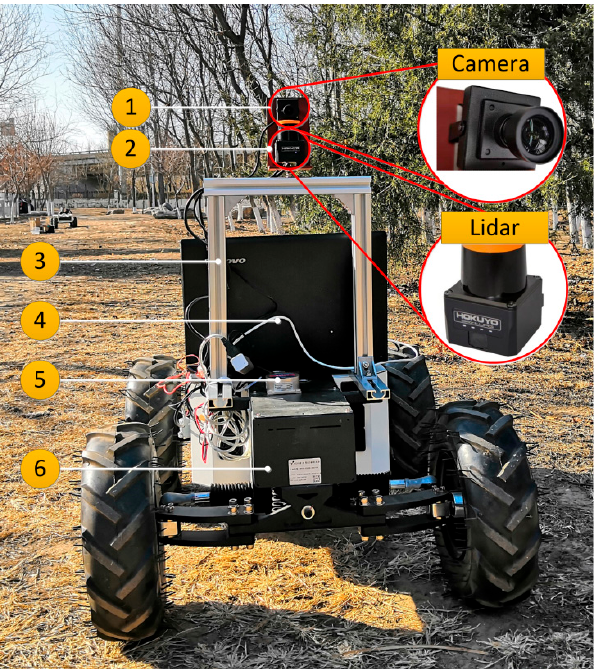
Figure 2. The self-built forestry UGV platform, equipped with a CCD monocular vision camera and a 2D lidar. 1. CCD monocular vision camera; 2. Two-dimensional lidar; 3. Sensor bracket; 4. Epigynous machine; 5. Gyro; 6. Ackerman chassis.